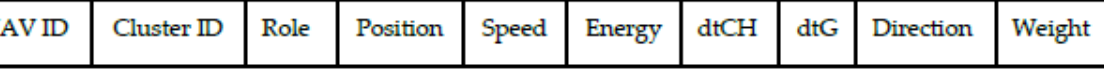
Figure 2. HELLO message structure.